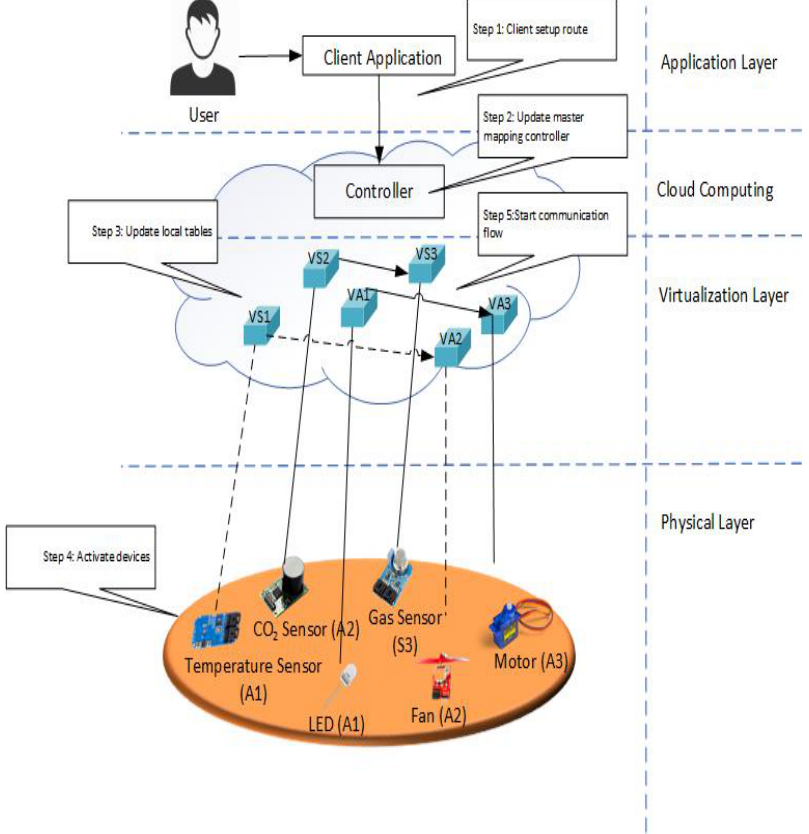
Figure 8. Development configuration and flow of the virtual IoT